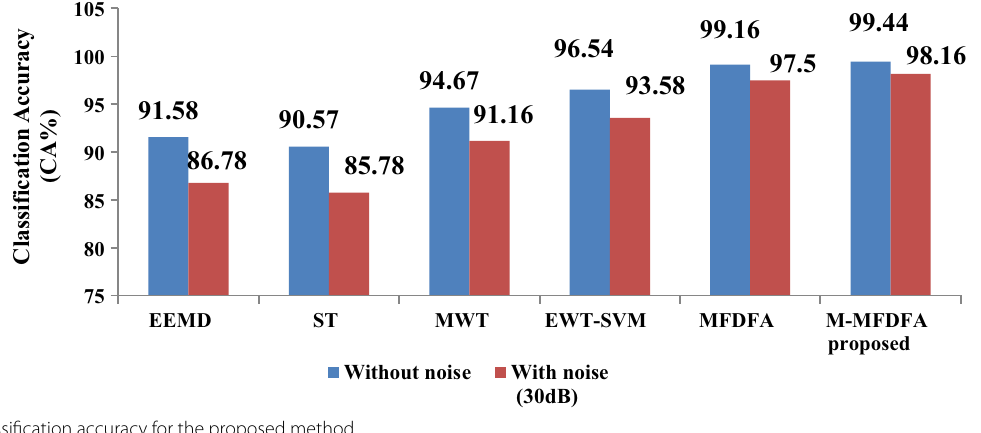
Fig. 20 Classification accuracy for the proposed method